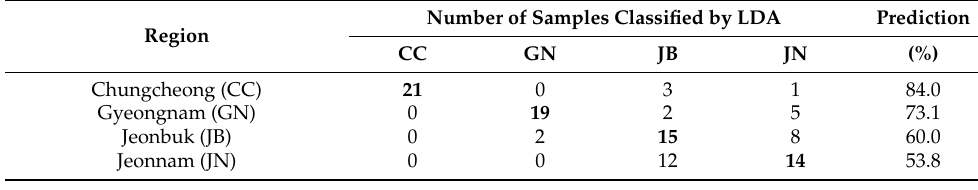
Table 2. Predicted geographical origins of each clam from different provinces of Korea. The number of individual clams with geographical origins defined by linear discriminant analysis (LDA) of C–N stable isotope combinations. Each number represents a sample classified by that predicted region, and the prediction was calculated using the number of samples (bolds) whose origin was well identified out of the total samples. The results were evaluated using cross-validation.